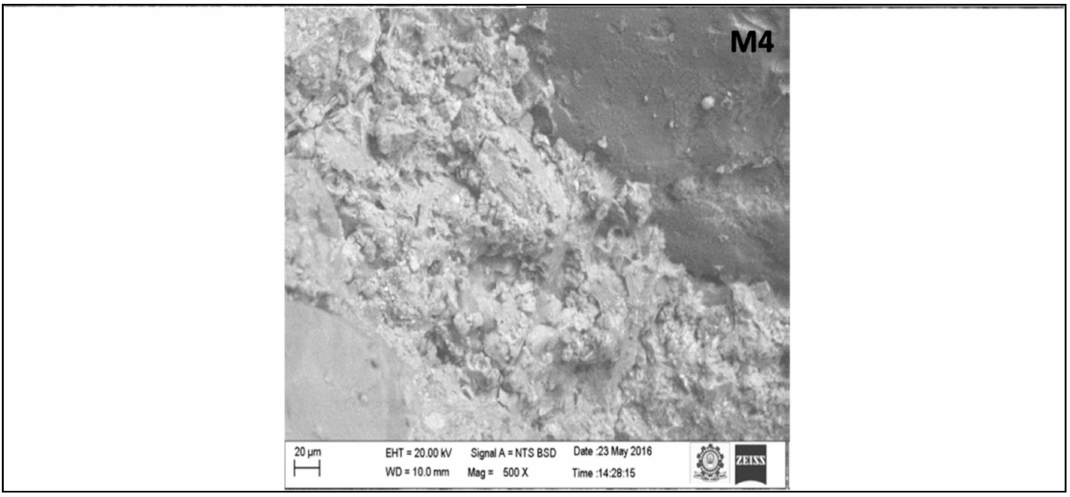
Figure 16. SEM images of various concrete mixes.